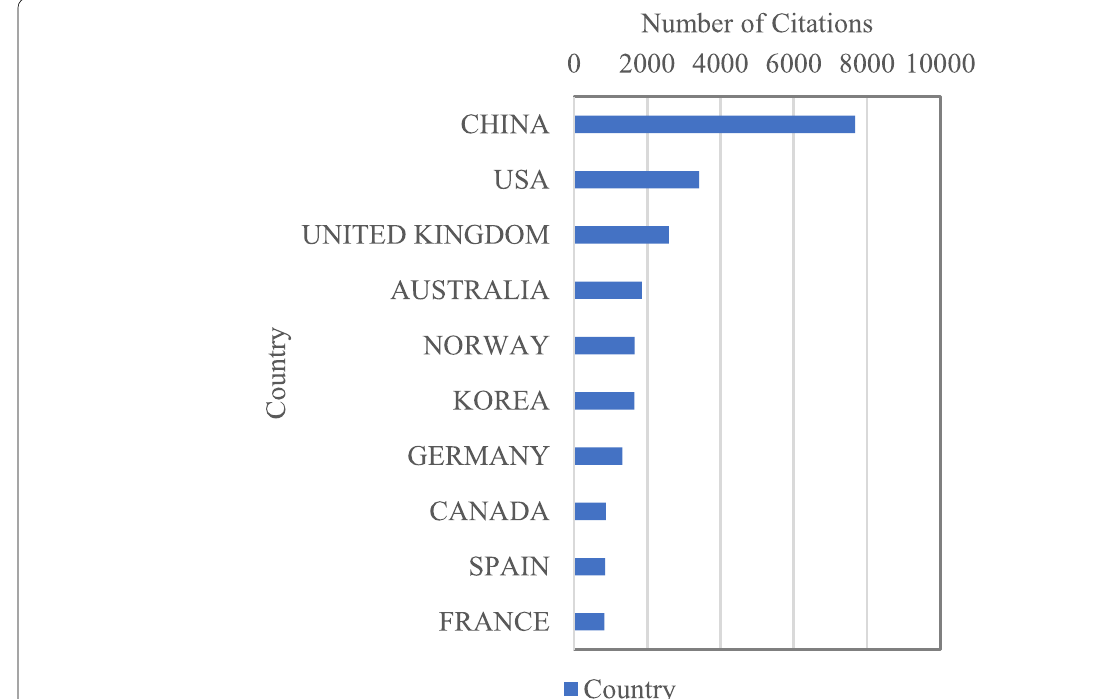
Fig. 25 Absorbent, top cited countries